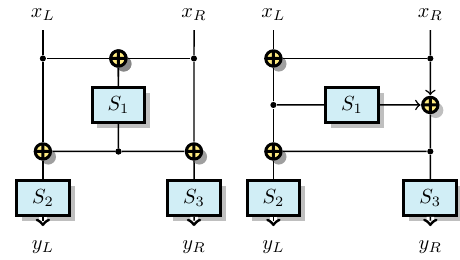
Figure 4(a): 3-round Feistel (left) and inverse (right).